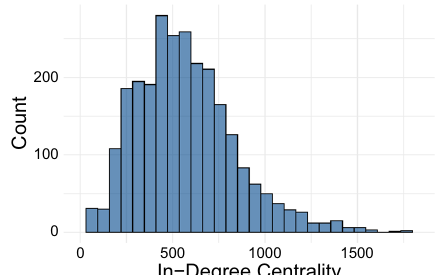
Fig. 4 Distribution of in-degree centrality for hexagon cells in the interpolated mobility network